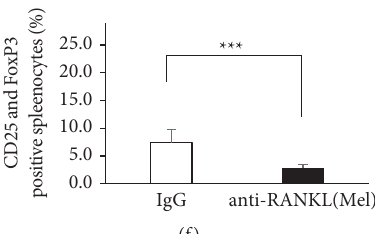
Figure 4: Flow cytometry analysis of thymocytes, PBMCs, and splenocytes. (a) Flow cytometric analysis of thymocytes from IgG and anti- RANKL/Mel. Thymocytes were analyzed for CD4 and CD8 expression. The numbers indicate the percent of total thymocytes that fall within the indicated quadrants. (b) Flow cytometric analysis of PBMCs from IgG and anti-RANKL/Mel. Thymocytes were analyzed for CD4 and CD8 expression. The numbers indicate the percent of total thymocytes that fall within the indicated quadrants. (c) Flow cytometric analysis of splenocytes from IgG and anti-RANKL/Me. Splenocytes were analysed for CD4 and CD8 expression. The numbers indicate the percent of total thymocytes that fall within the indicated quadrants. (d) Percent of CD4 SP, CD8 SP, and CD4CD8 DP cells in IgG and anti-RANKL/ Mel. (e) Percent of CD4 SP, CD8 SP, and CD4CD8 DP cells in IgG and anti-RANKL/Mel mice. (f) Percent of CD25 and FoxP3 positive Treg cells in and anti-RANKL/Mel. Graphs show mean ± SEM. ∗∗∗ p < 0 .